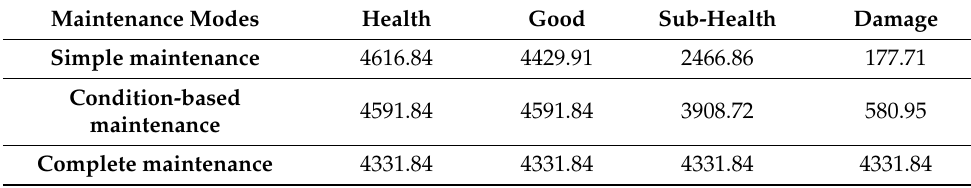
Table 2. Revenue from different maintenance